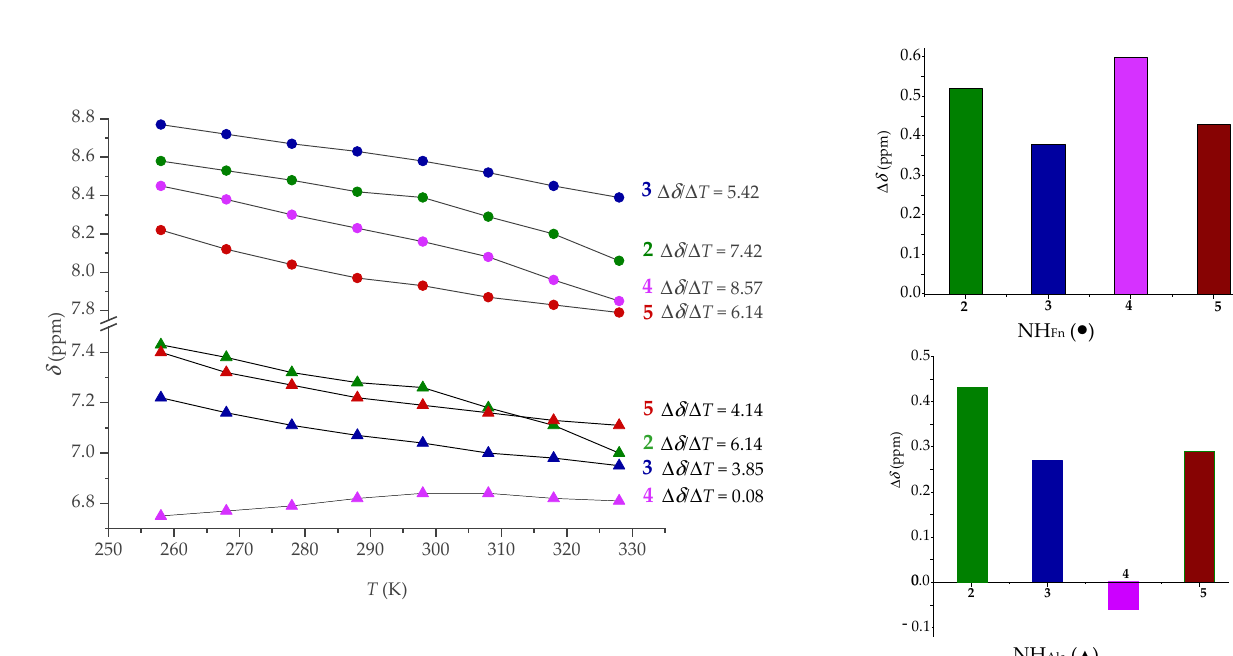
• ) and NH Ala ( ▲ ) in peptides 2 – 5 in CDCl 3 from 258–328 K ( c = 1 × 10 − 3